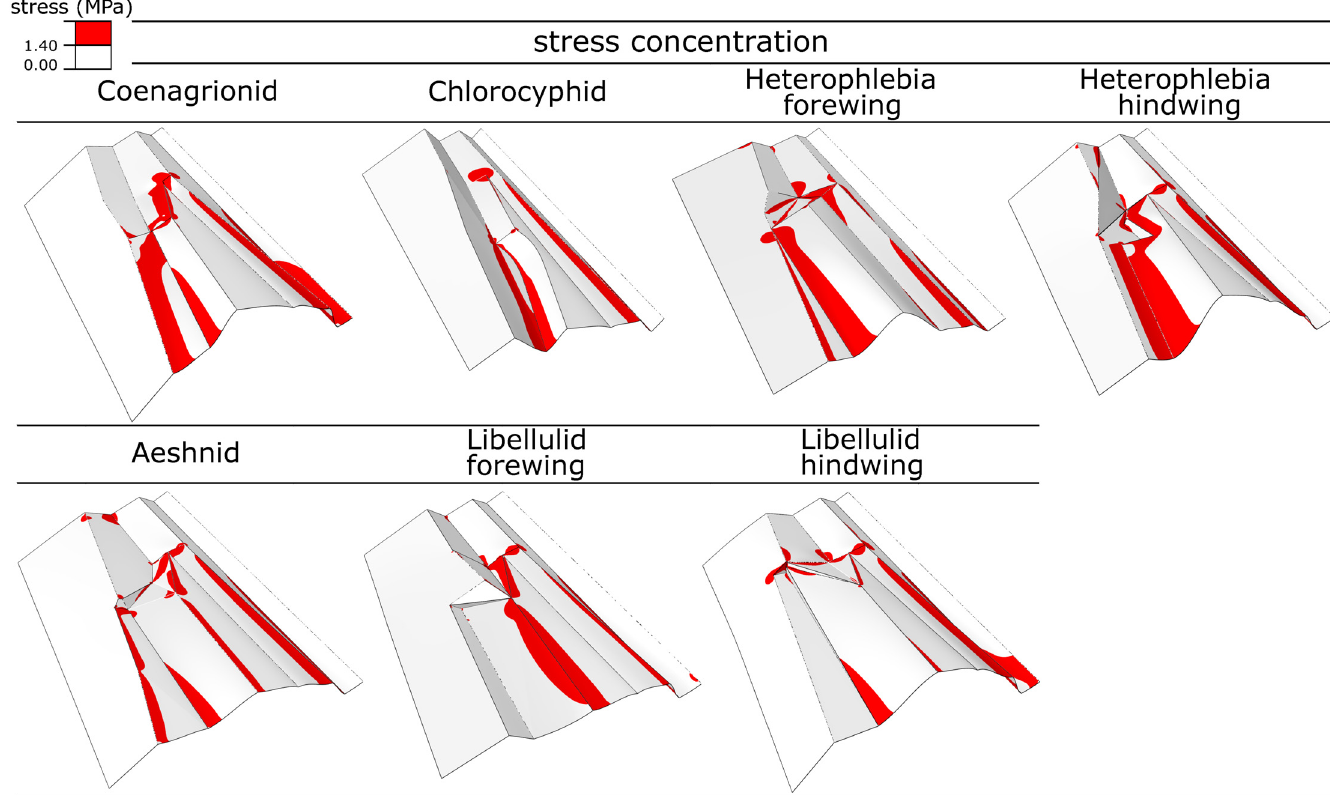
Fig 5. Localized stress in the realistic models (Group 1). The models are subjected to 0.19 mN point force applied to RP from the ventral side. The regions with the maximum principal stress larger than 5% of the ultimate tensile strength of the wing material are marked with the red